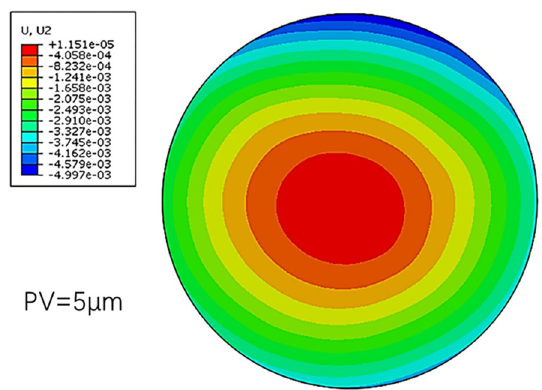
Figure 10 Deformation finite element simulation result with even material removal of upper and lower